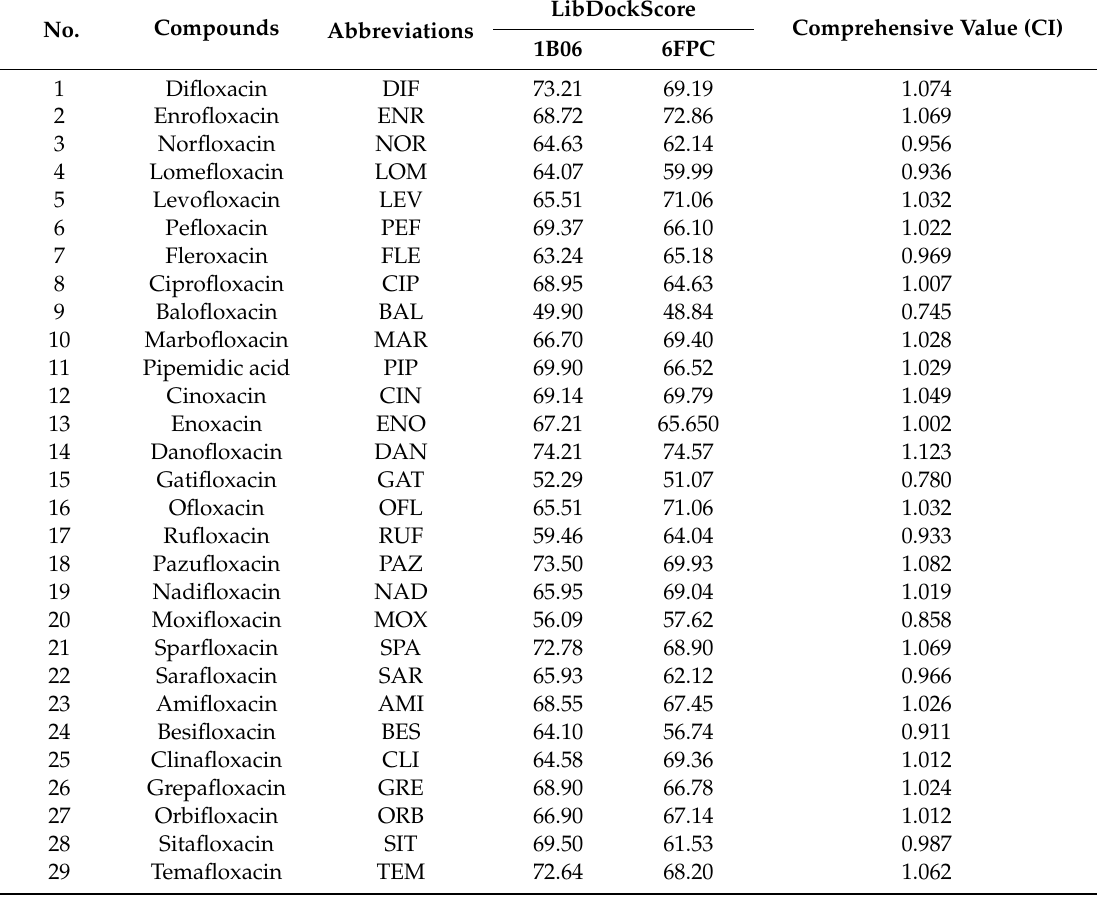
Table 2. Calculation of CI of the biotoxicity of QNs (quinolones) on